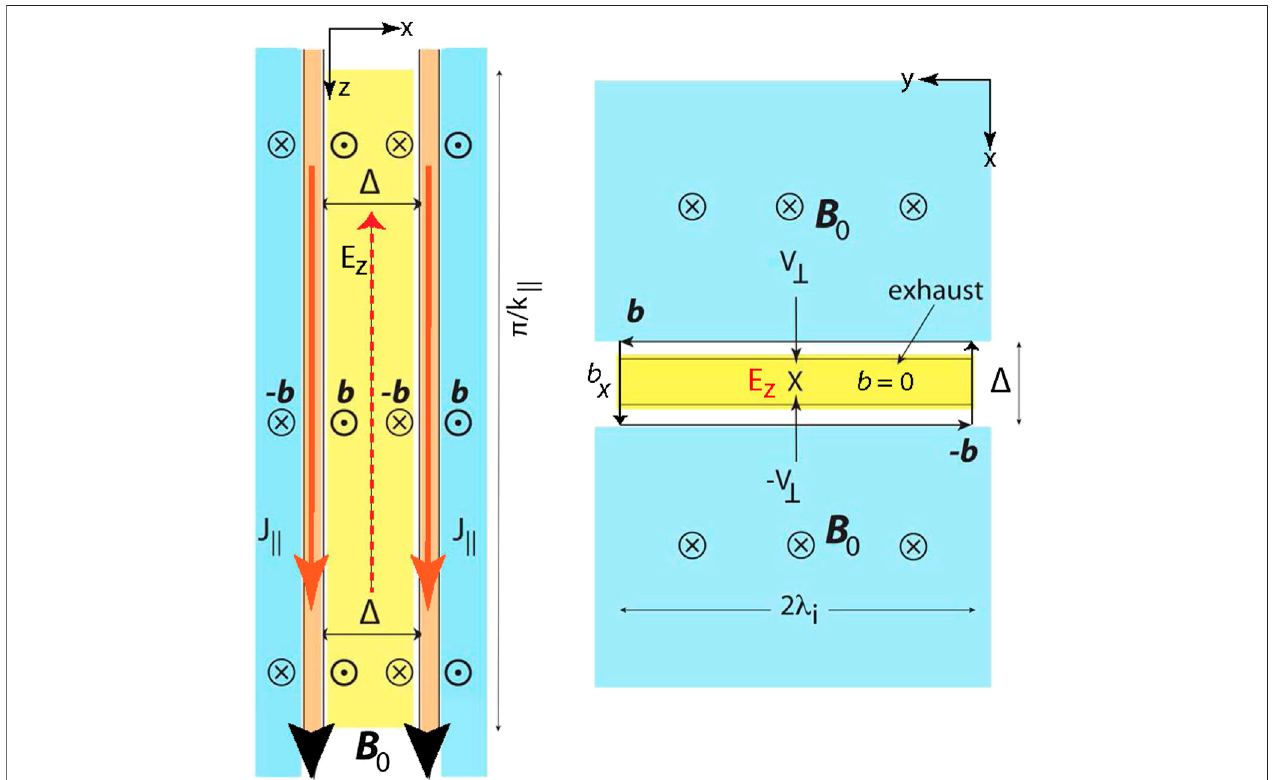
FIGURE4| Schematicofthe fi eldcon fi gurationbetweentwoparallel fi eldaligned fl uxtubesinthedownwardcurrentregion.Left:Geometryalongtheambient fi eld. Currents are in red. Included would be the (red dashed) fi ctitious return current which locally would correspond to the antiparallel wave magnetic fi elds ± b . This current would be local over the wavelength of the inertial Alfvén wave. In any stationary reconnecting current picture it would be this current whose magnetic fi eld reconnects. However, here this current does not exist in the exhaust. It is completely reconnected and gives rise to the reconnection electric fi eld E z instead (dashed red) in the exhaust along the main magnetic fi eld. Electrons are directly accelerated by italongB 0 . Right: Reconnection geometry with perpendicular velocity V ⊥ , fi eld freeexhaust, reconnection fi elds ± b x indicated, and E z . The anomalous collisions caused in the exhaust volume also permit for weak diffusion of the ambient fi eld. This may cause what is believed to be magnetic fi eld diffusion, a very slow process compared to the wave/current induced spontaneous reconnection.